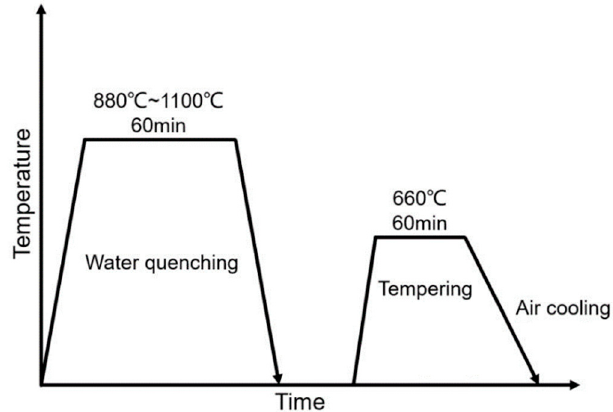
Figure 2. Schematic representation of processing schedule of experimental steels.